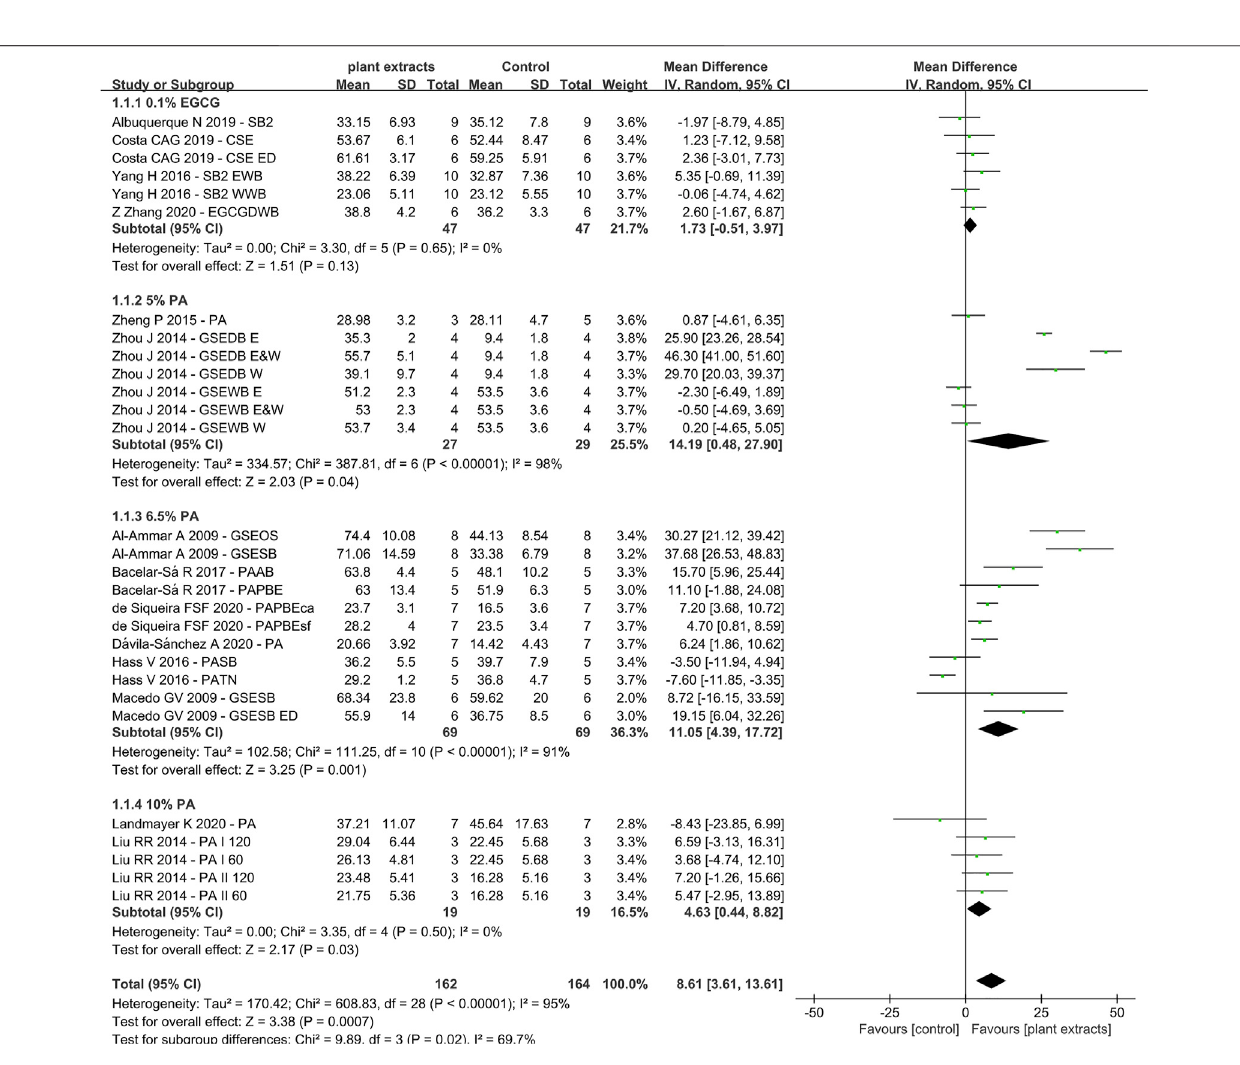
Frontiers in Bioengineering and Biotechnology |